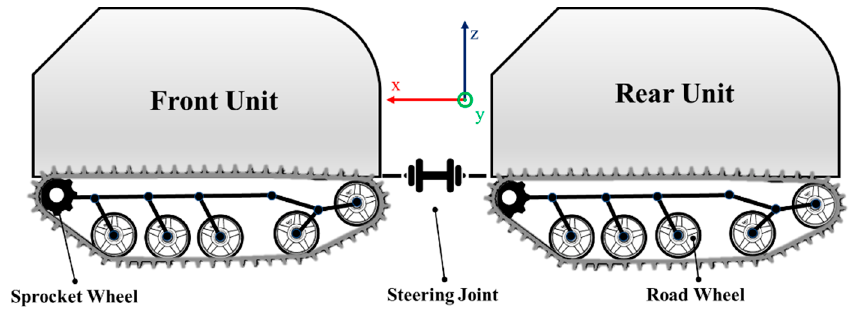
Figure 1. Simplified schematic of the articulated tracked vehicle (ATV).